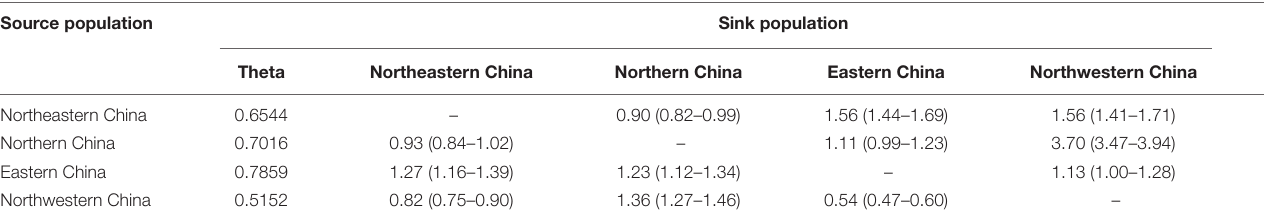
TABLE 8 | Estimates of the mean population mutation rate (2 N e µ ) and mean number of migrants per generation M (2 N e m ). Source